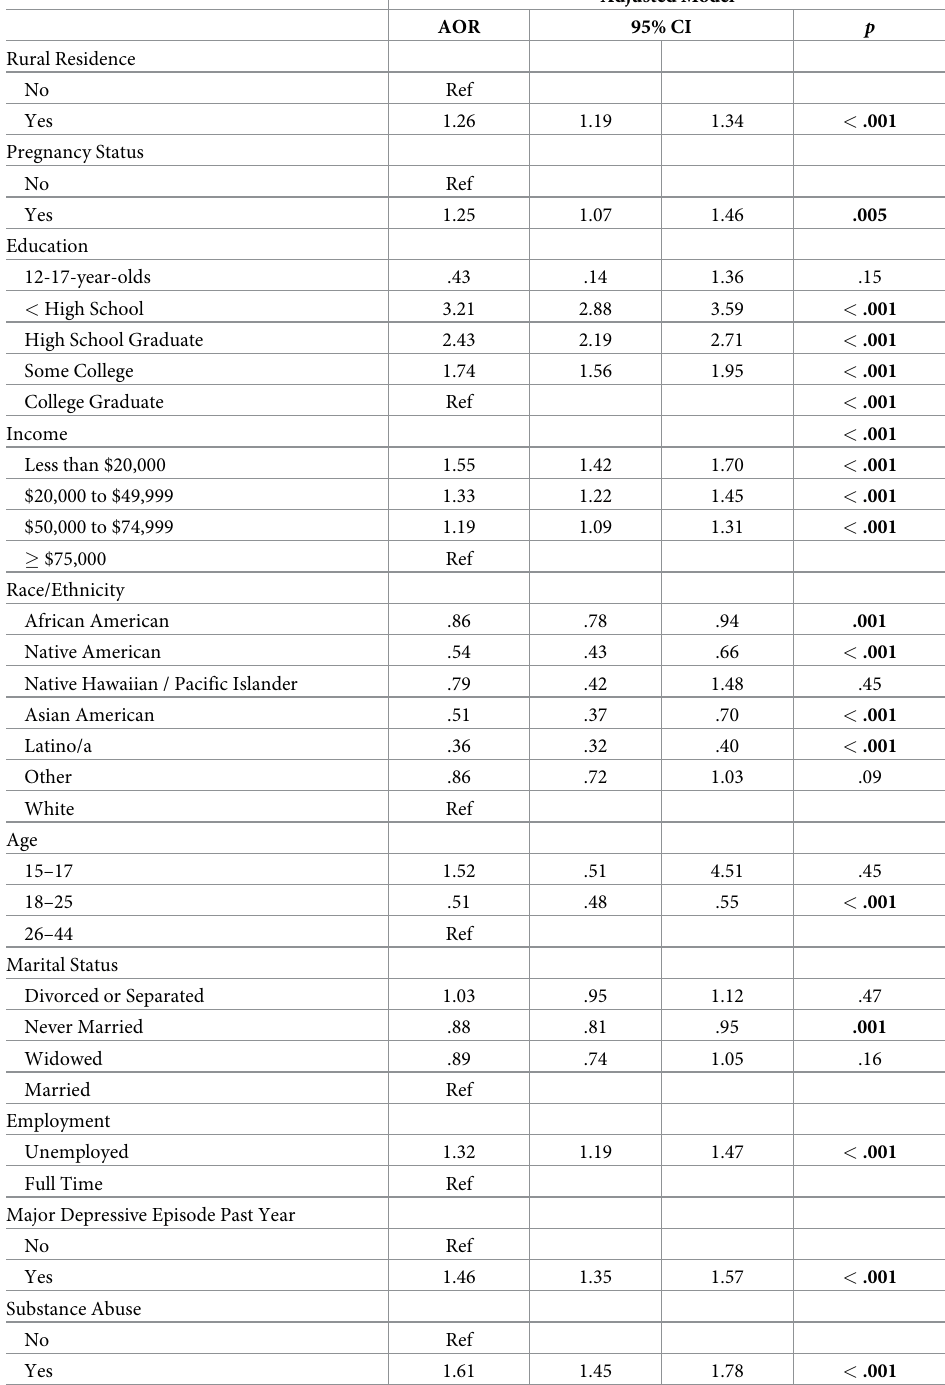
Table 3. Adjusted multivariable logistic regression coefficients for a model of nicotine dependence (in current smokers only) in the US between the years